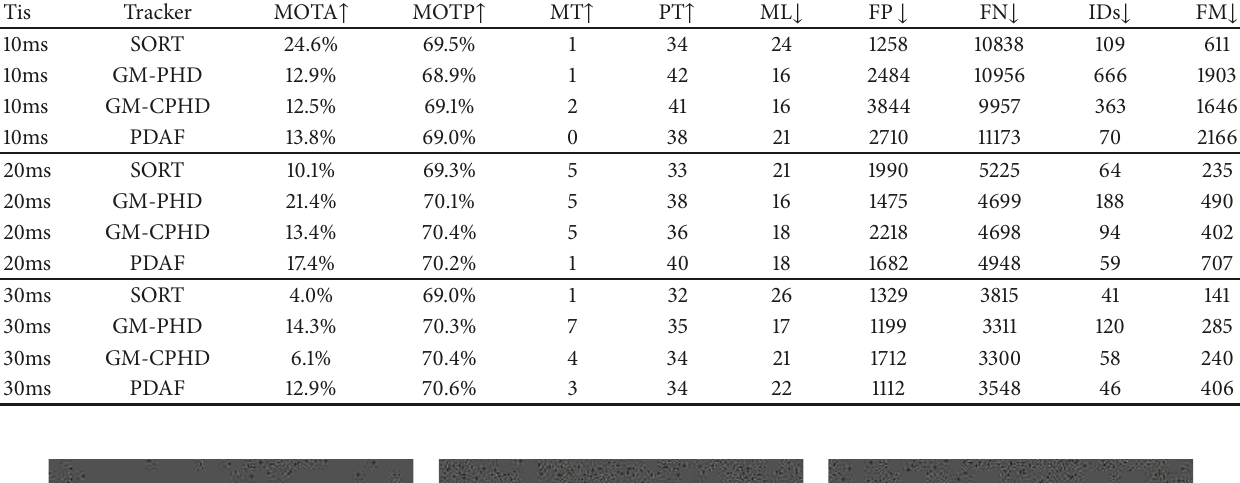
Table 6: The tracking performance for EventSeq-Vehicle3using different tracking methods (SORT, GM-PHD, GM-CPHD, and PDAF) with detection through DBSCAN clustering. The impact of time intervals from 10ms to 30ms was studied.